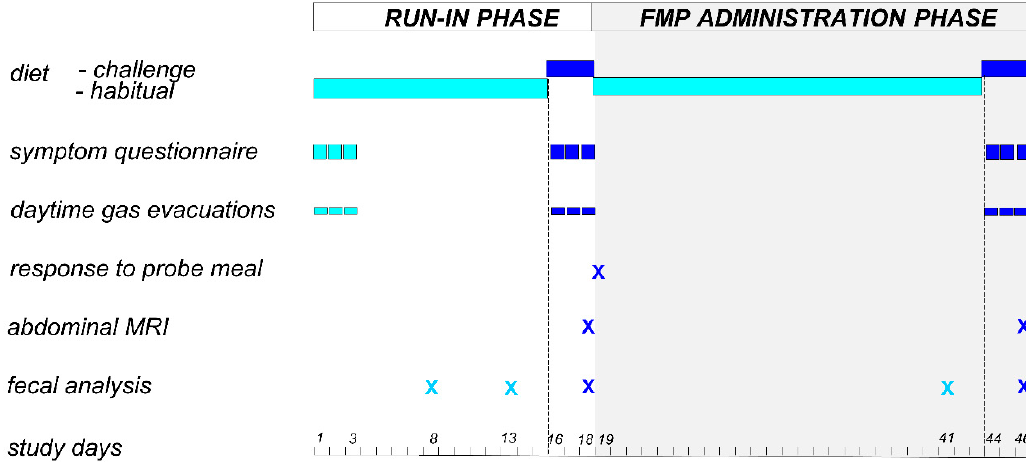
Figure 1. Study design. FMP: fermented milk product.